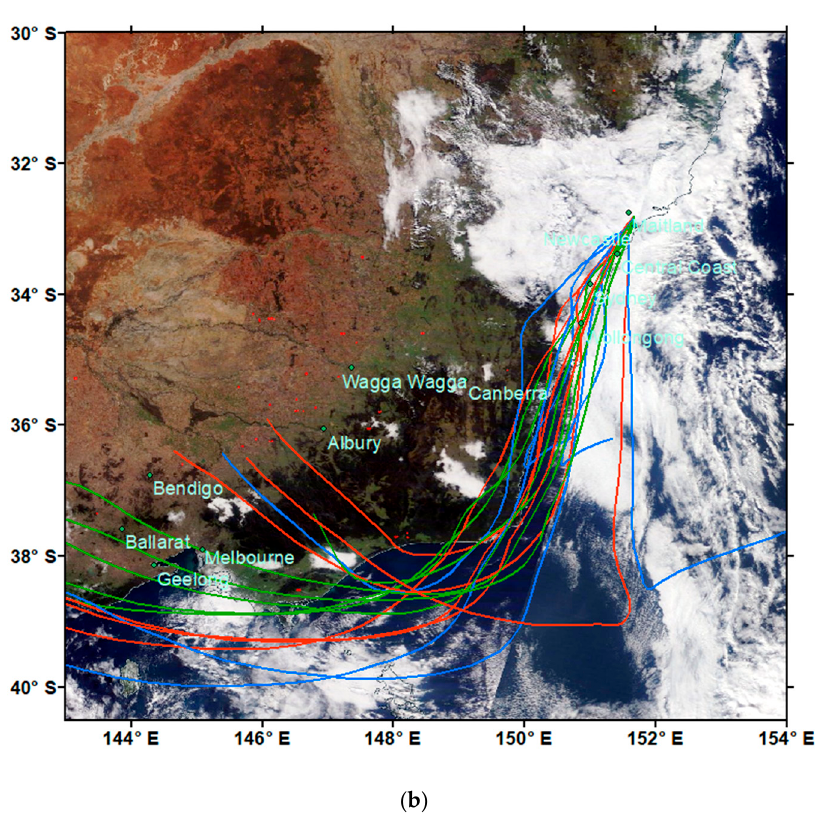
Figure 8. ( a ) BC from fossil fuel combustion (BC ff ) and from biomass burning (BC wb ) as measured by AE33 aethalometer for May 2015 at Beresfield. Note that, on 6 May 2015, there was also a dust storm from the region west of Beresfield. ( b ) HYSPLIT ensemble backward trajectory for 48 h from Beresfield at 10-m height on 4 May 2015 5:00 UTC (15:00 AEST local time).